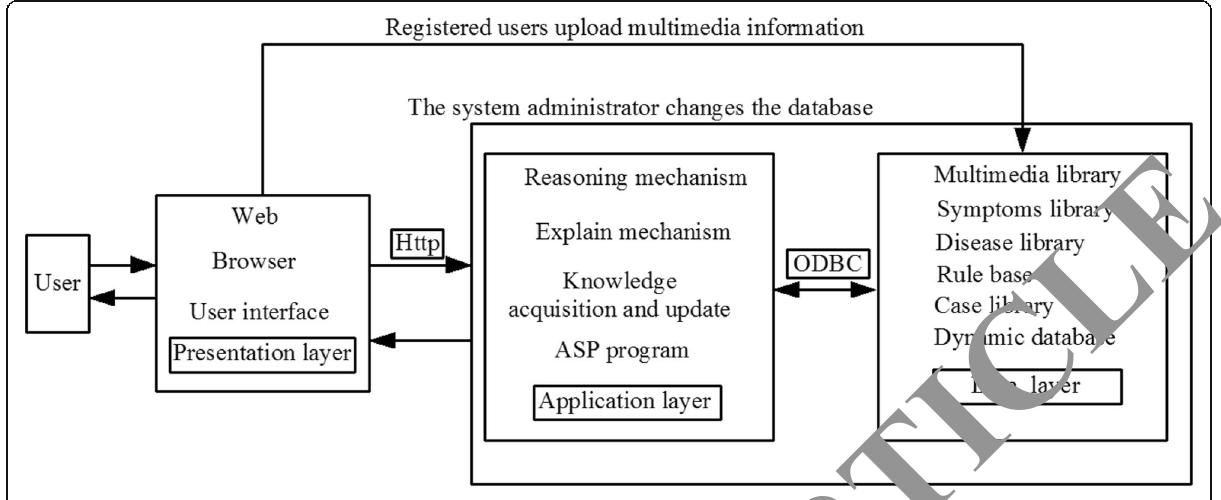
Fig. 1 Based on the annealing algorithm, the measures to improve the judicial execution plan in the administrative law